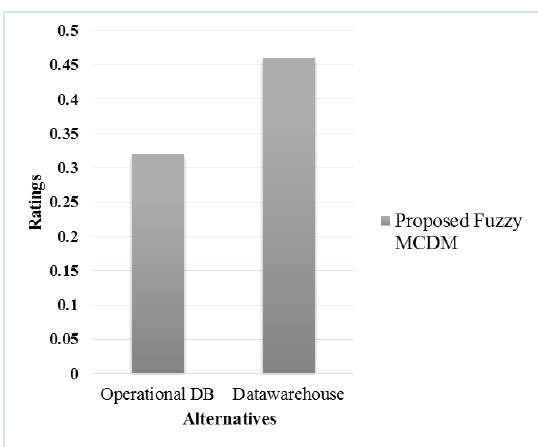
Figure 2. Rating with TFN-based decision-making